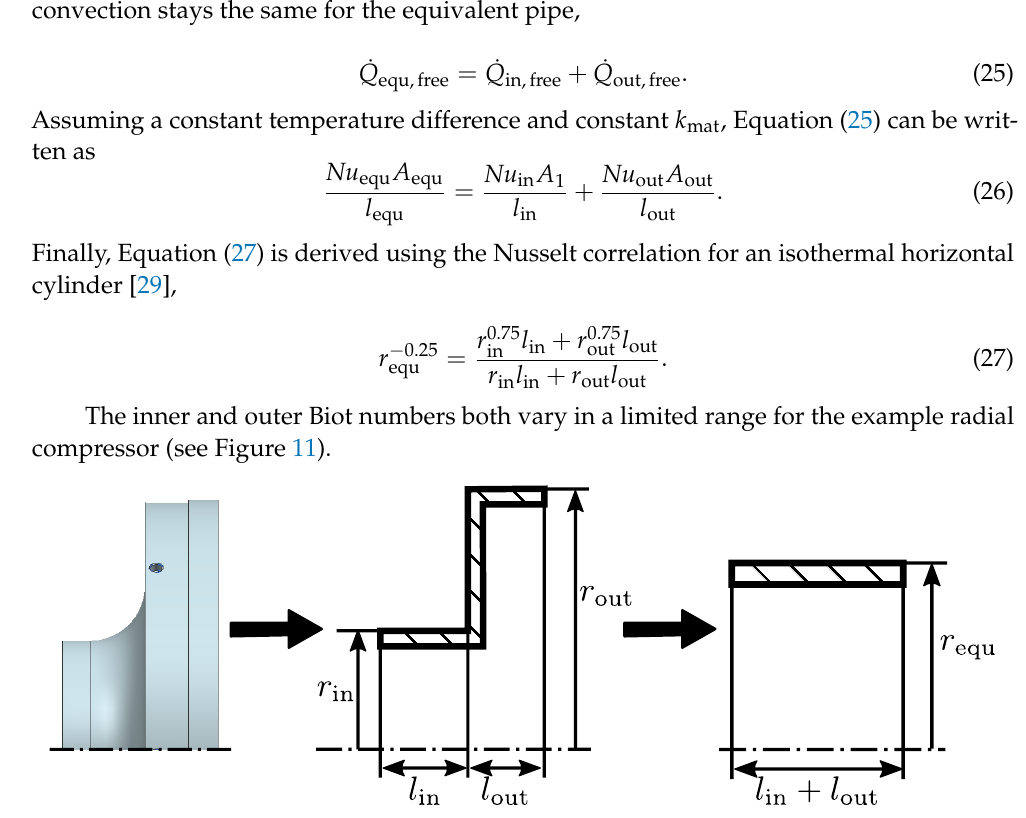
Figure 10. Modeling the compressor casing as an equivalent